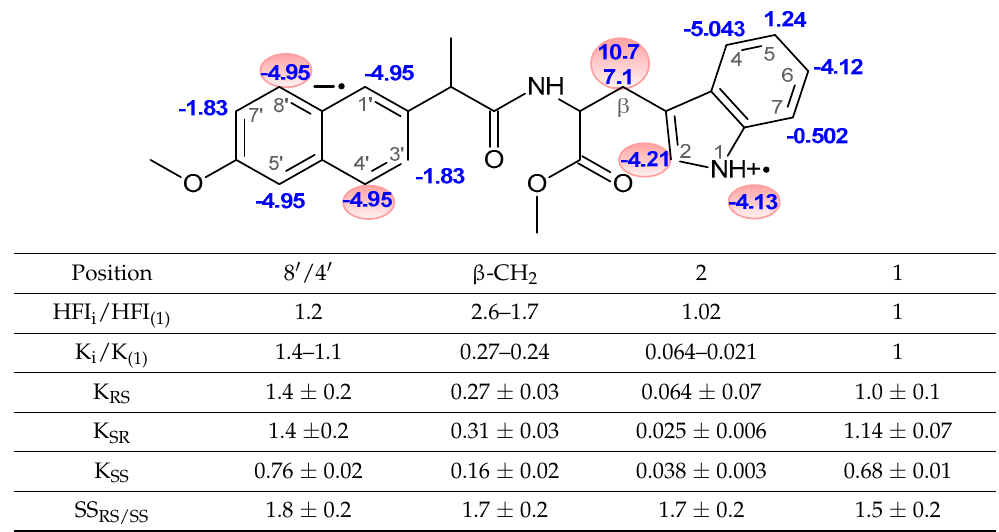
Table 2. The ratios of HFI constants and observed CIDNP coefficients (K) relative to 1-NH and the values of observed CIDNP coefficients for protons of diastereomers of dyad I in CD 3 CN [20].